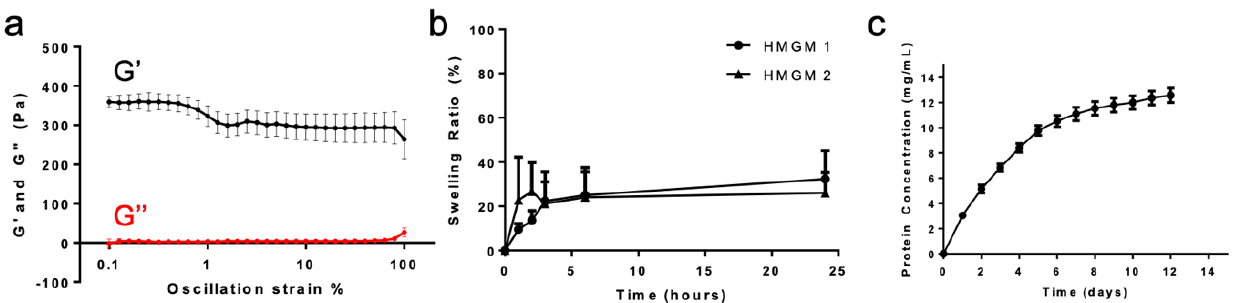
Figure 5. Physical HMGM Hydrogel Characterization. ( a ) Oscillation strain (0.1–100%) rheological results. Storage modulus (G ′ ) and loss modulus (G ″ ) are indicated. ( b ) Swelling Ratio %. ( c ) Cumulative total protein release over 12 days.